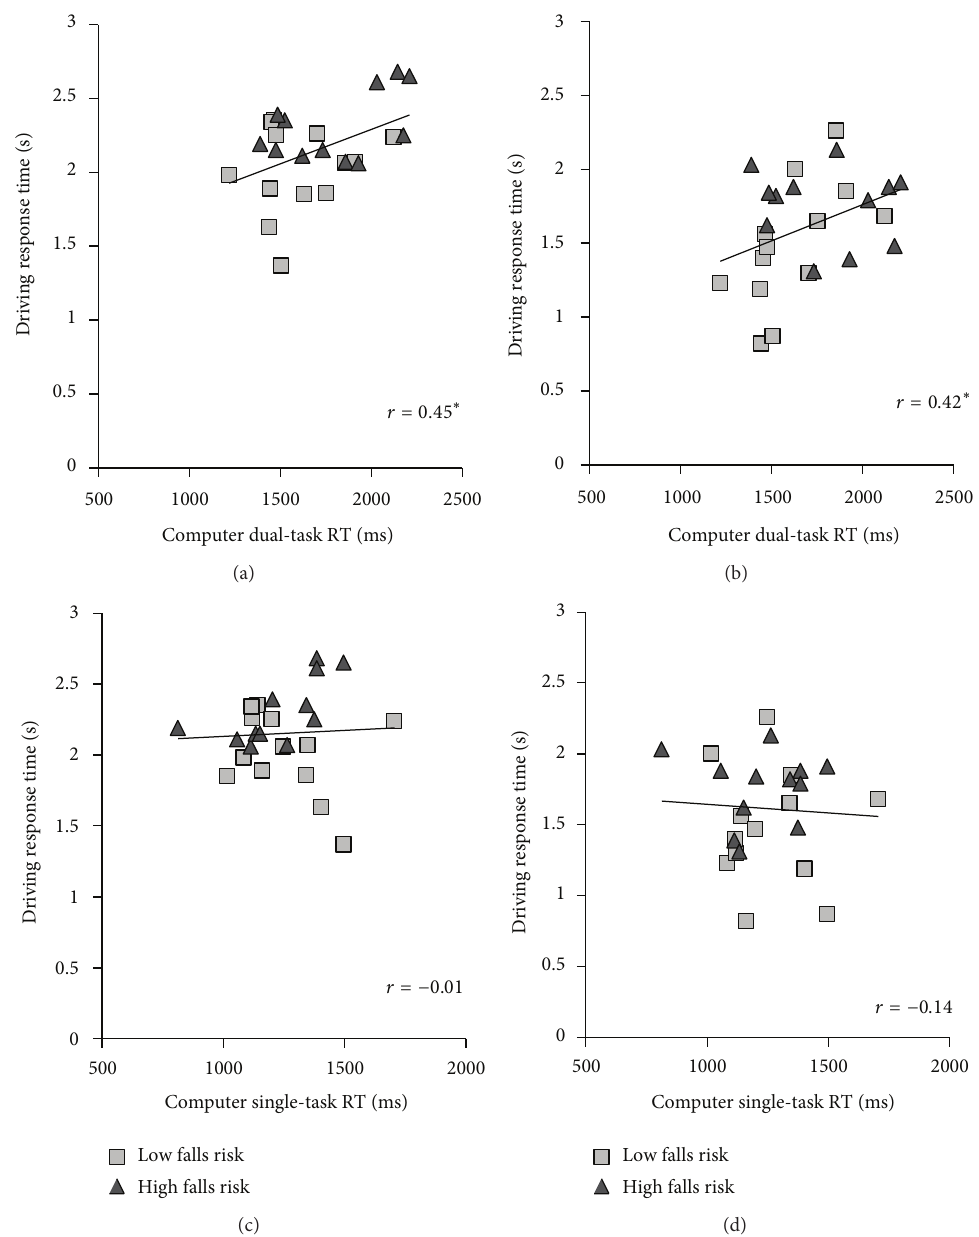
Figure 3: Driving response times and dual-task performance. Response time in seconds in the hazard (a) and (c) and following (b) and (d) driving tasks plotted against single-task and dual-task reaction time in milliseconds on the computer dual-task paradigm. ∗ 𝑃 < .05 .